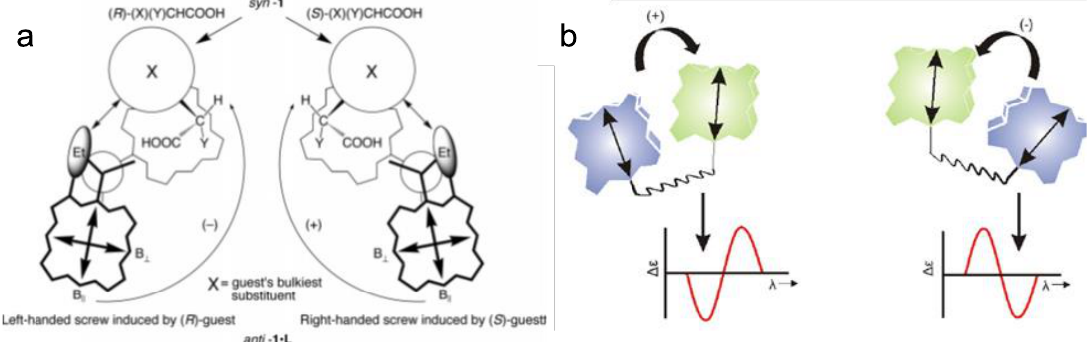
Figure 11. ( a ) Supramolecular chirogenesis in a bis-porphyrin tweezer upon interaction with a chiral acid. ( b ) Exciton coupling of porphyrins with relative positive or negative twist [35–37].